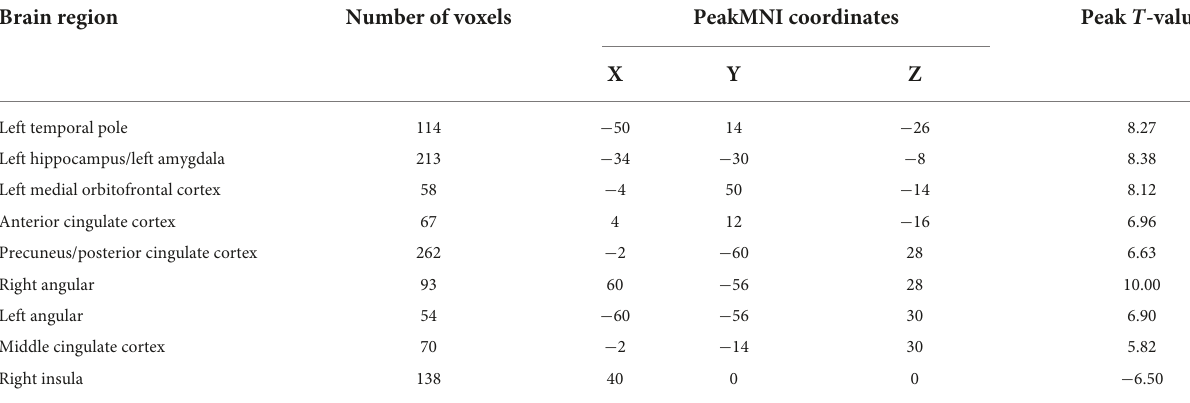
TABLE 3 Brain regions showing significant differences of the right SFGmed-based functional connectivity in the aSAH group as compared to the healthy controls. Brain region Number of voxels PeakMNI coordinates Peak T -value